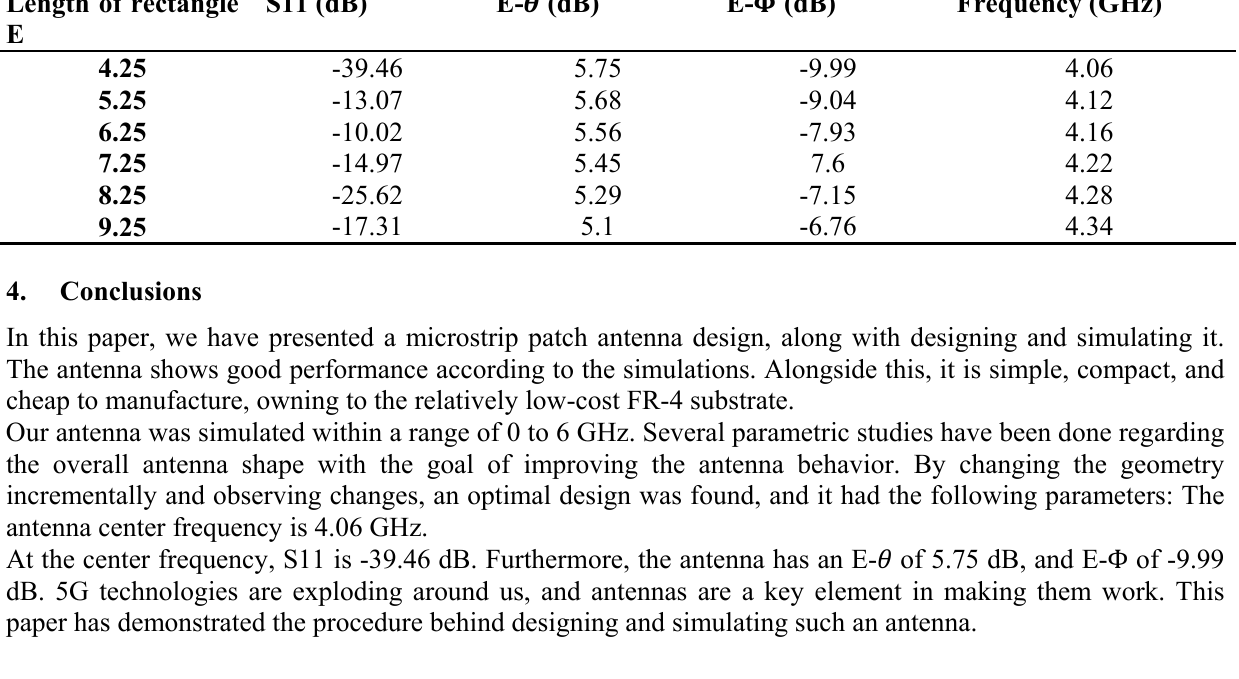
Table 5. Results of fifth parametric study Length of